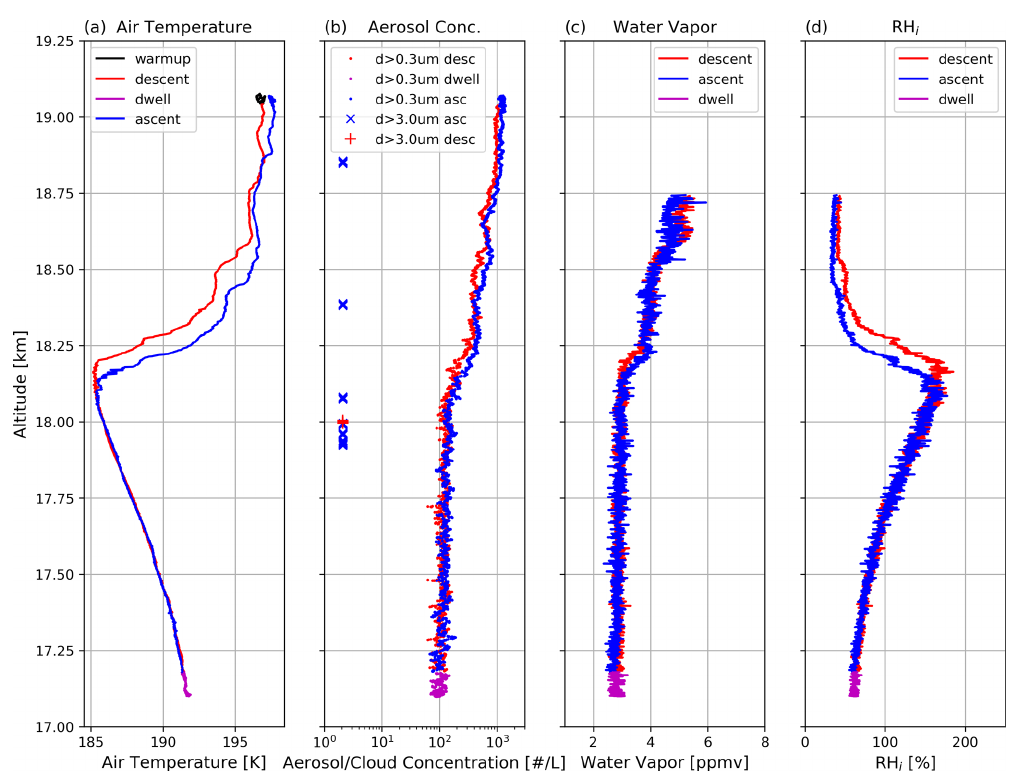
Figure 8. RACHuTS profile measurement collected in the eastern Pacific. All plots are a function of GPS altitude (left to right). (a) TSEN air temperature; note the clear cold point (185K) at 18.2km and wave-driven temperature structures near 18.4 and 18.9km on ascent. (b) ROPC aerosol or cloud concentration; note the presence of large particles ( d> 3 . 0µm), likely cirrus cloud ice particles, near the cold point (18.2km) associated with negative temperature anomalies at 18.4 and 18.9km. (c) FLASH-B water vapor mixing ratio; note the relatively constant mixing ratio across the cold point (18.2km). (d) Calculated relative humidity over ice; near the cold-point supersaturations exceed 150% suggesting minimal dehydration through cloud